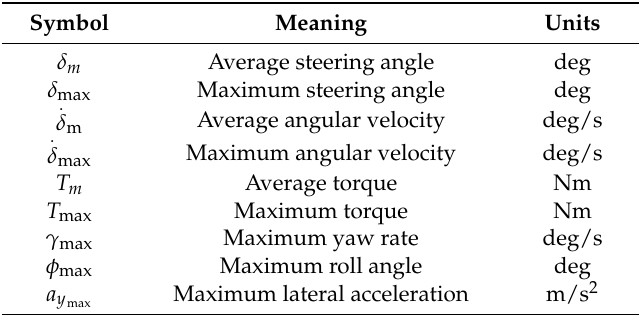
Table 2. Driver’s characteristic steering parameters.